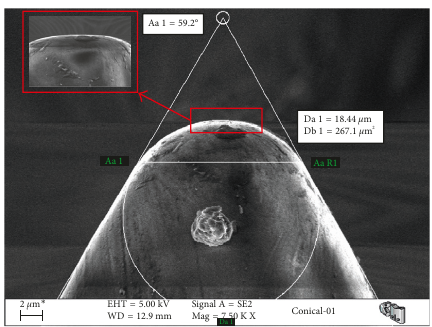
Figure 2: Scanning electron microscope image of a worn diamond conical-spherical indenter.